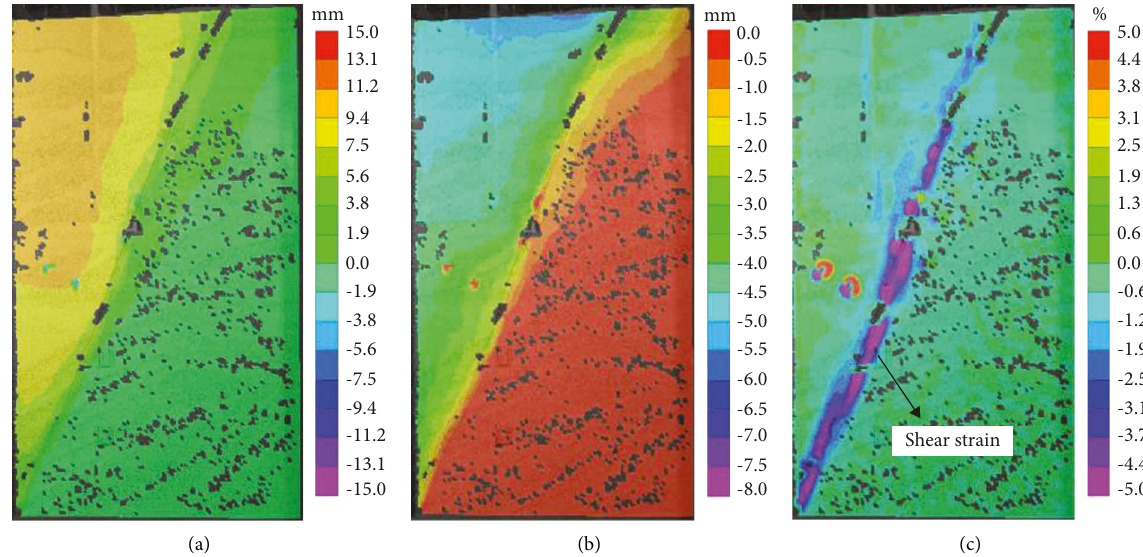
Figure 9: The ground displacement field in sample M1; (a) the vertical settlement, (b) the horizontal displacement, and (c) the shear strain.